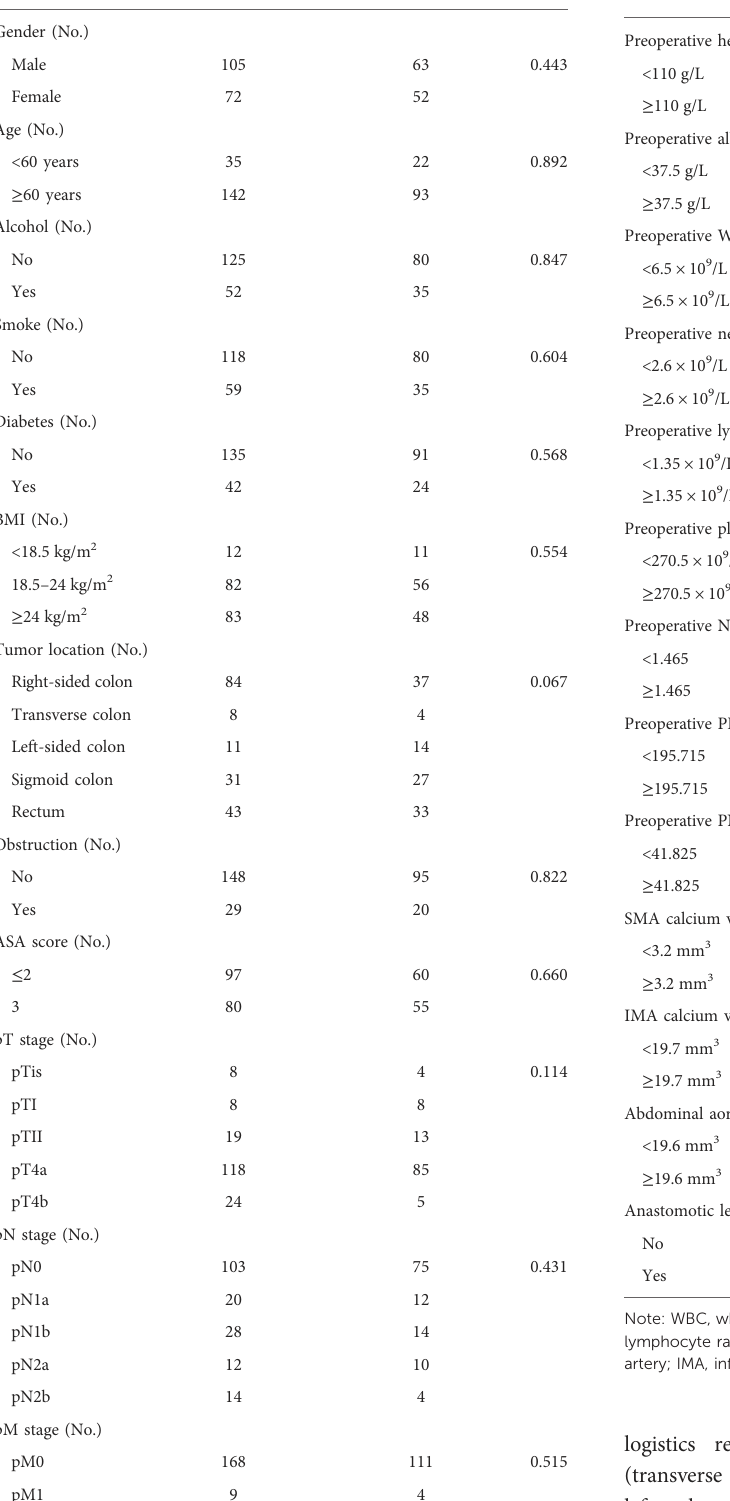
logistics regression model. We observed tumor location (transverse colon, OR: 2.891, 95% CI: 0.194 – 43.017, P = 0.441; left colon, OR: 10.417, 95% CI: 0.668 – 162.511, P = 0.095; sigmoid colon, OR: 12.162, 95% CI: 2.213 – 66.836, P = 0.004;